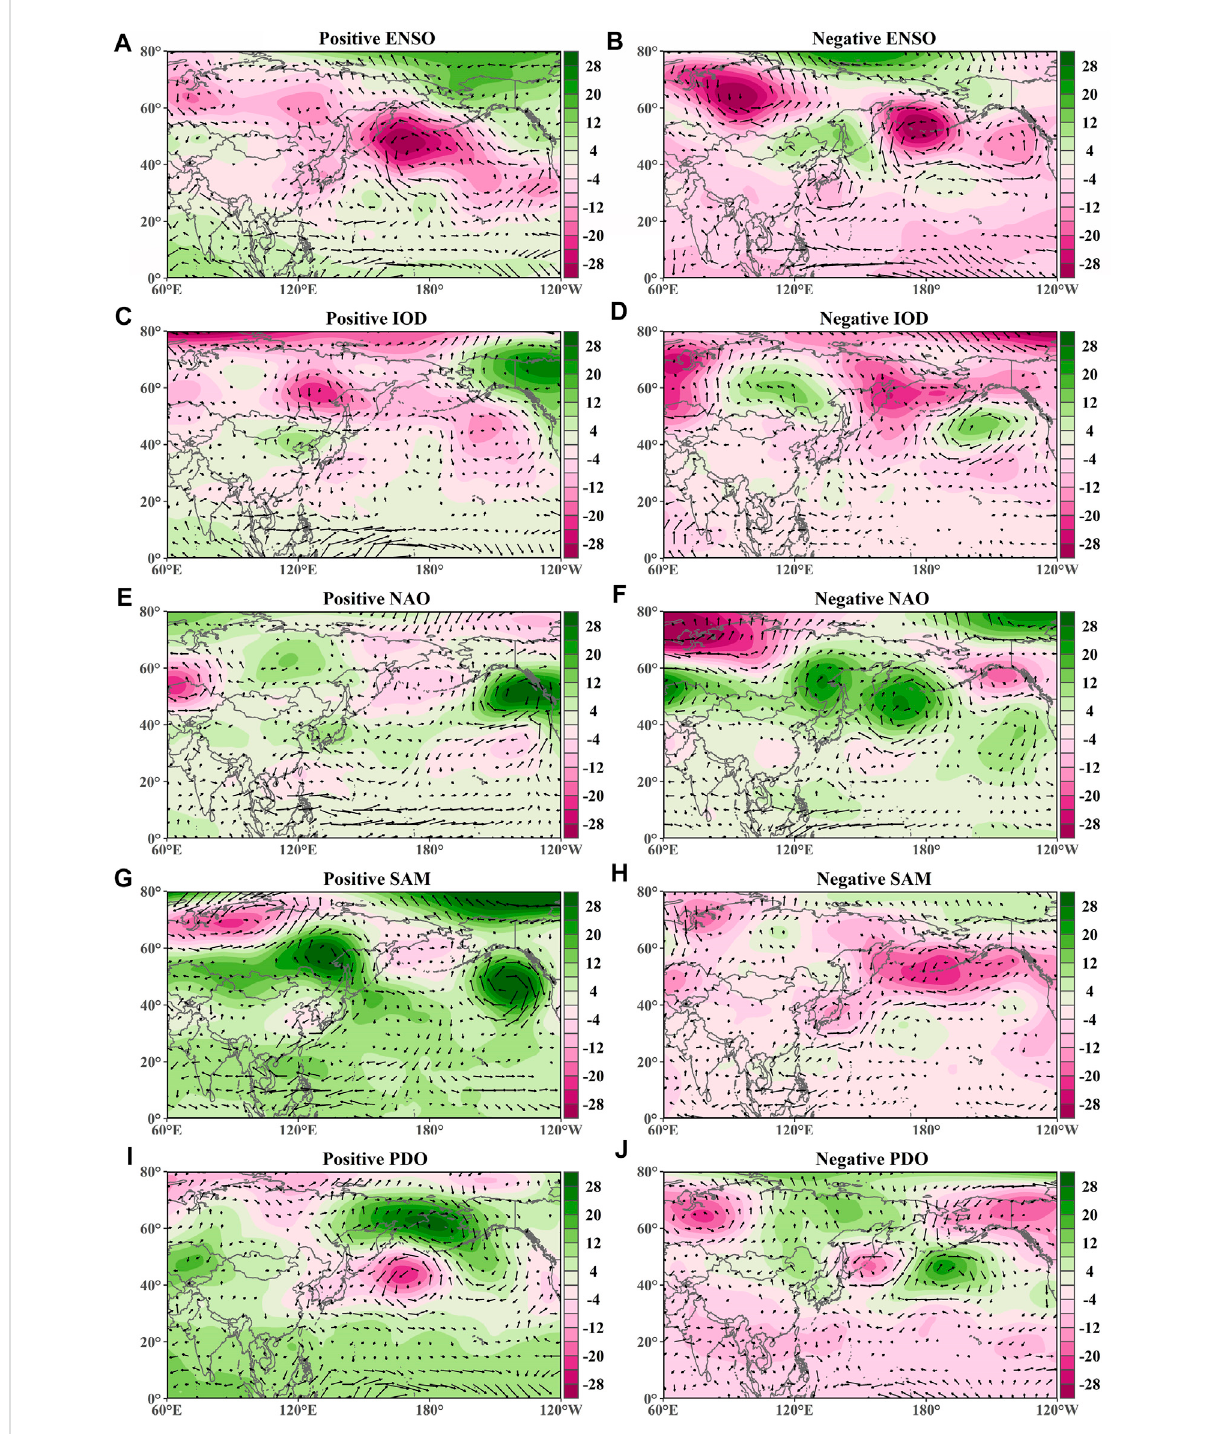
FIGURE 9 The same as Figure 8 but for 500-hPa potential height (shadows) and 850-hPa wind fi eld (arrows)